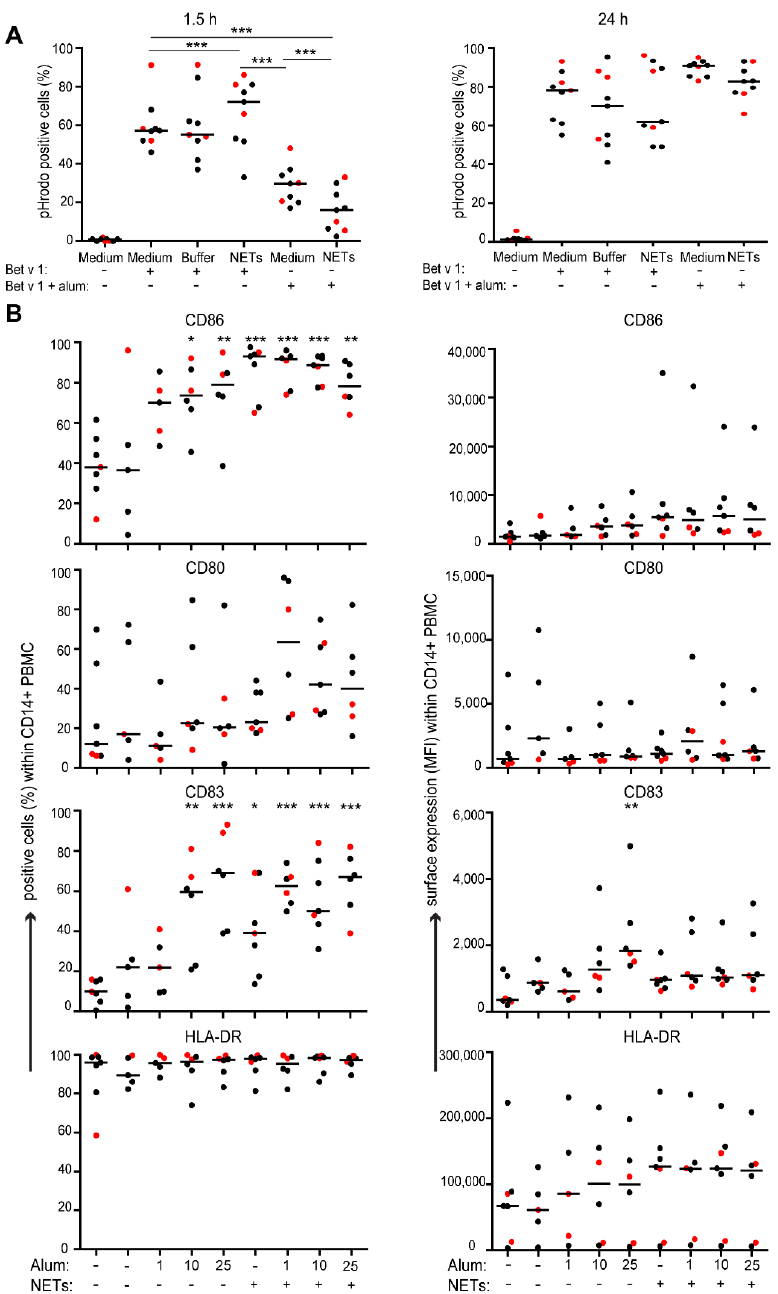
Figure 5. Effects of alum and NETs on antigen uptake and surface molecules involved in antigen-presentation. ( A ) Peripheral blood mononuclear cells (PBMC) were pre-incubated for 1.5 h with isolated NETs (100 ng/mL), NET buffer or medium alone. Then pHrodo-labelled Bet v 1 (1 µ g/mL) or Bet v 1-pHrodo (1 µ g/mL) that had been pre-adsorbed to alum (10 µ g/mL) for 30 min was added. The percentages of CD14 + Bet v 1-pHrodo + cells were quantified after 1.5 h (left panel) and after 24 h (right panel) by flow cytometry. Cumulative data of 9 independent experiments with 9 different donors are shown. In Figure S4A one representative example is shown. ( B ) PBMC were incubated for 24 h with either medium, LPS (1 µ g/mL), pre-formed NET layers, or increasing doses of alum (1, 10, 25 µ g/mL) or alum in combination with NET layers, respectively. The percentages of positive cells within the CD14 + population and the mean fluorescence intensities (MFI) were quantified by flow cytometry for CD86, CD80, CD83 and HLA-DR. Cumulative data of 7 independent experiments with 7 different donors are shown. Red dots indicate allergic donors. Horizontal lines show medians. One-way ANOVA followed by Dunnett’s post tests (* p < 0.05; ** p < 0.01; *** p <